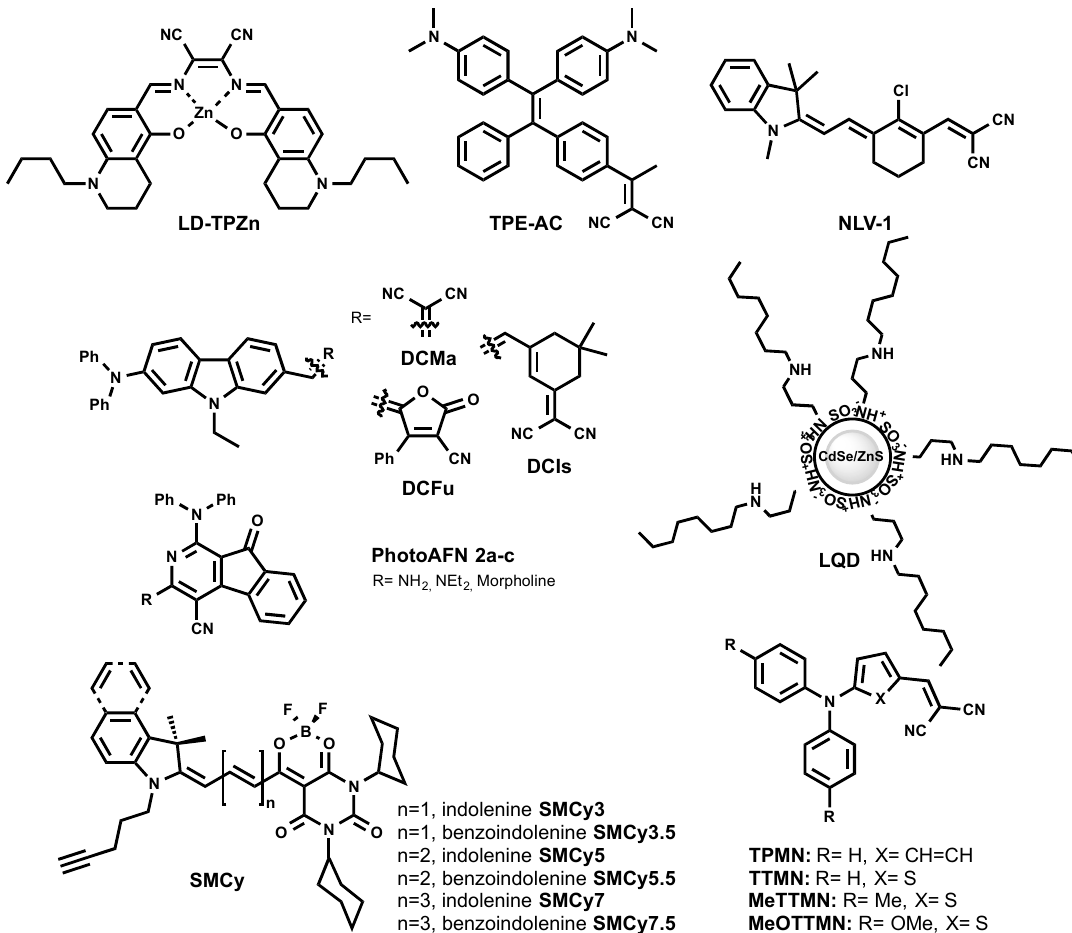
Figure 6. Chemical structures of red-emitting LD probes.